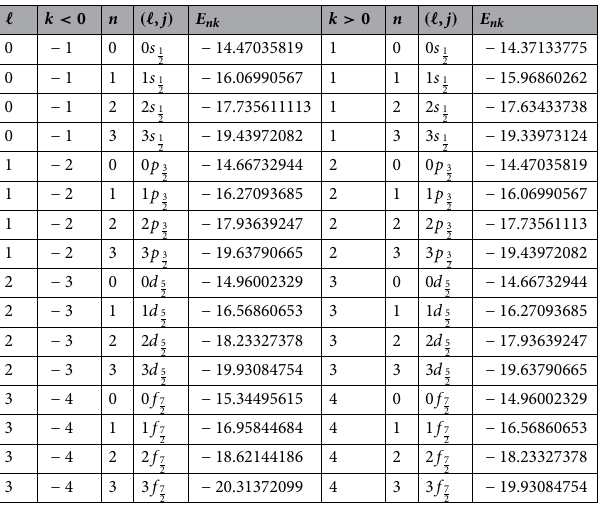
1 , v 1 , b 1 , 5 fm 15 fm 0.4, M 10 fm 1 − − − = = = =